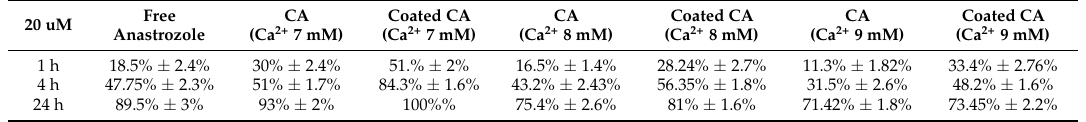
Table 9. Time-dependent cellular uptake of surface-modified and unmodified, anastrozole-loaded CA particles in MCF7 cell line. CA was formed with different Ca 2+ concentrations (7, 8 and 9 mM) and 20 µ M of anastrozole. Free anastrozole (20 µ M) was used as